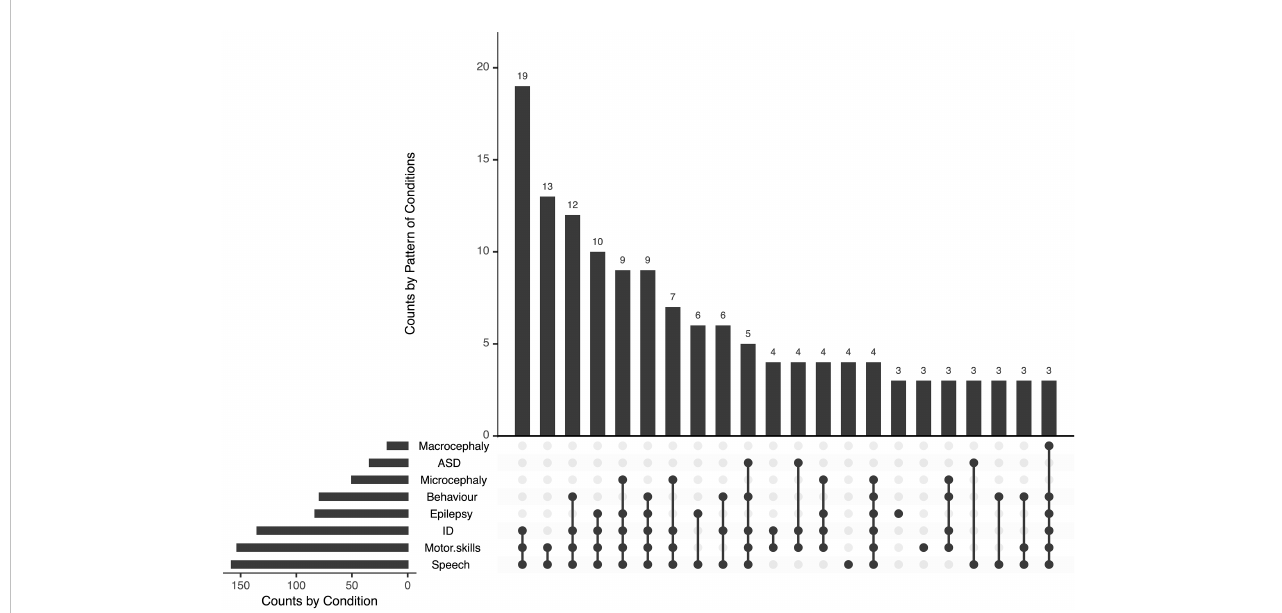
FIGURE 1 Phenotype of children of mothers tested for SYN1 autoantibodies. Developmental delay in the domains speech and motor skills were the most common fi ndings, often associated with intellectual disability and epilepsy. ID, intellectual disability; ASD, autism-spectrum